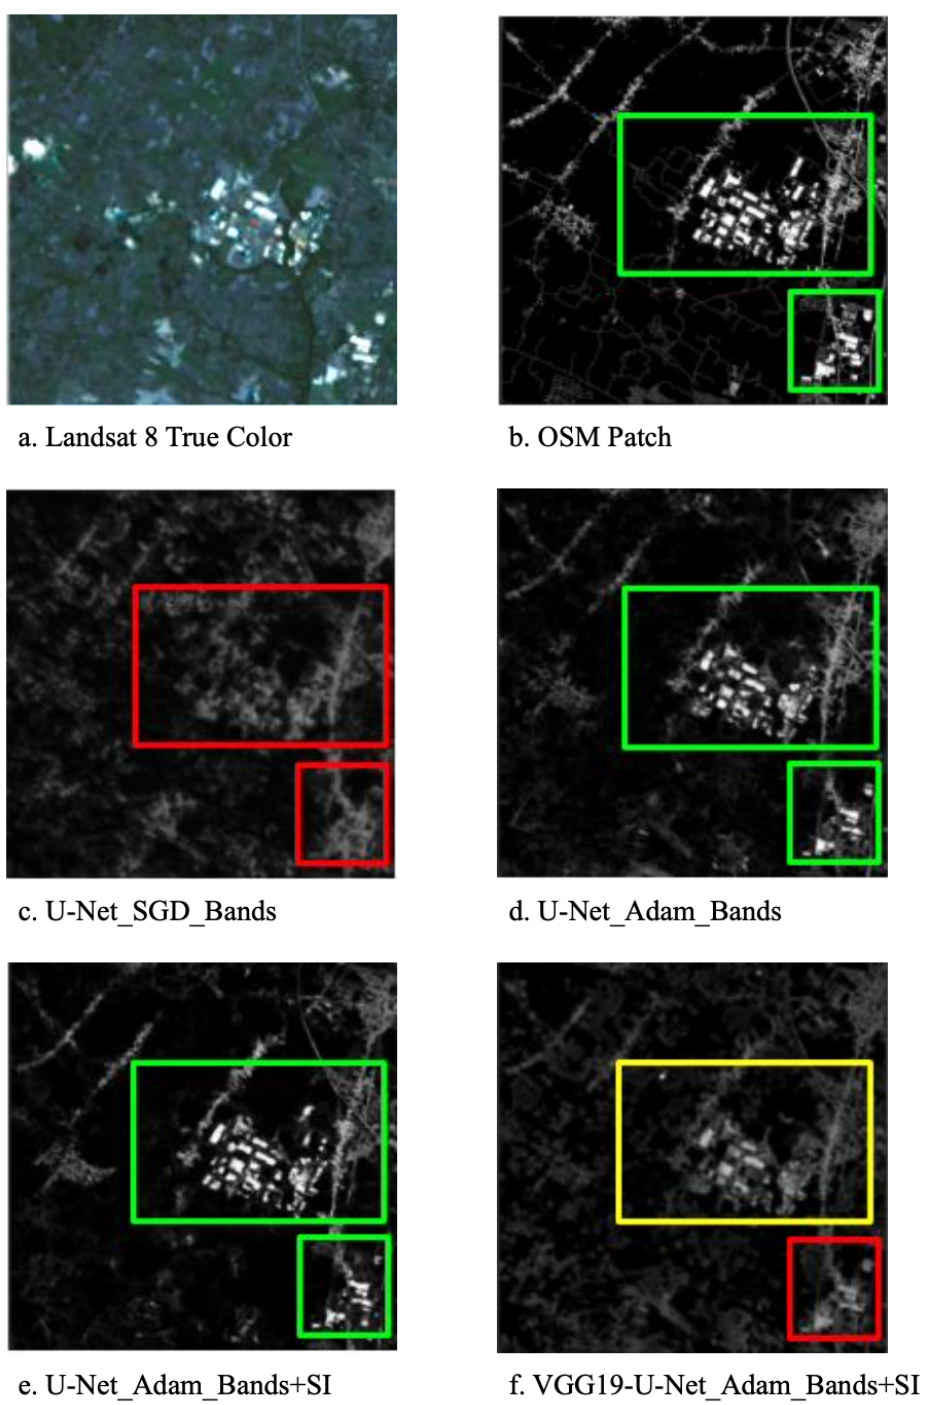
Figure 9. Impervious surface predictions from the four deep learning models on an image represent- ing a semi-urban